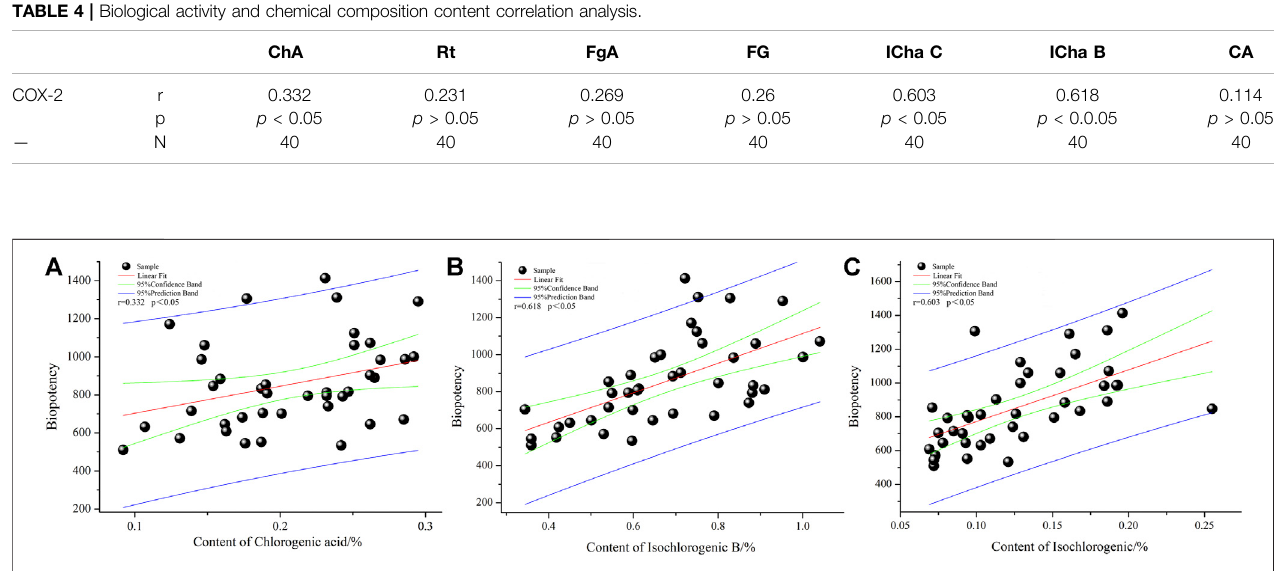
Frontiers in Pharmacology |